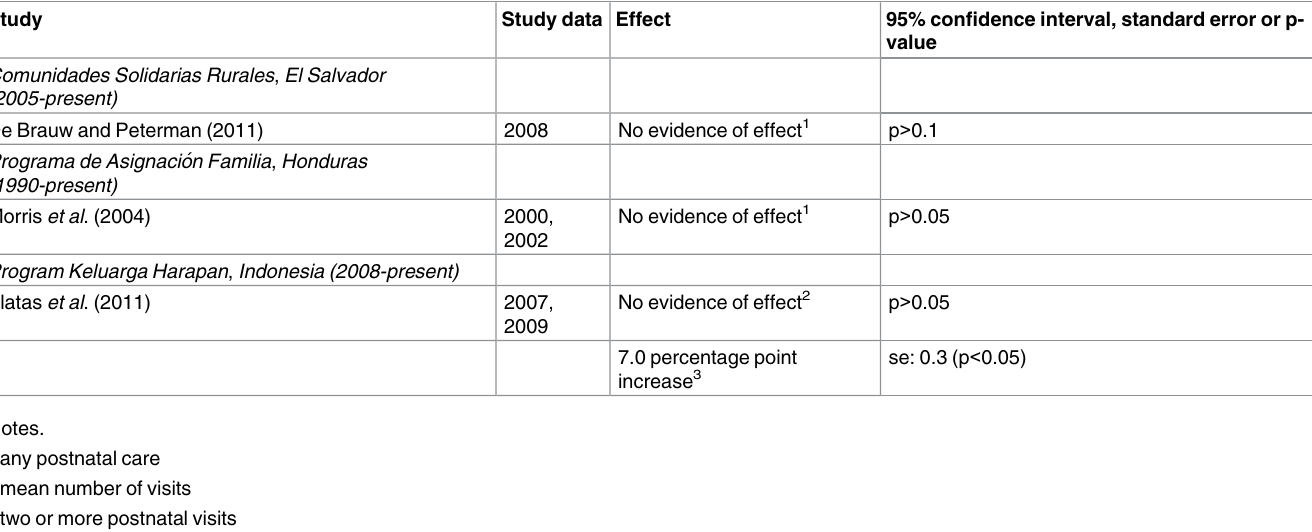
Table 4. Effect of conditional cash transferson uptake of postnatal care for mothers and newborns.